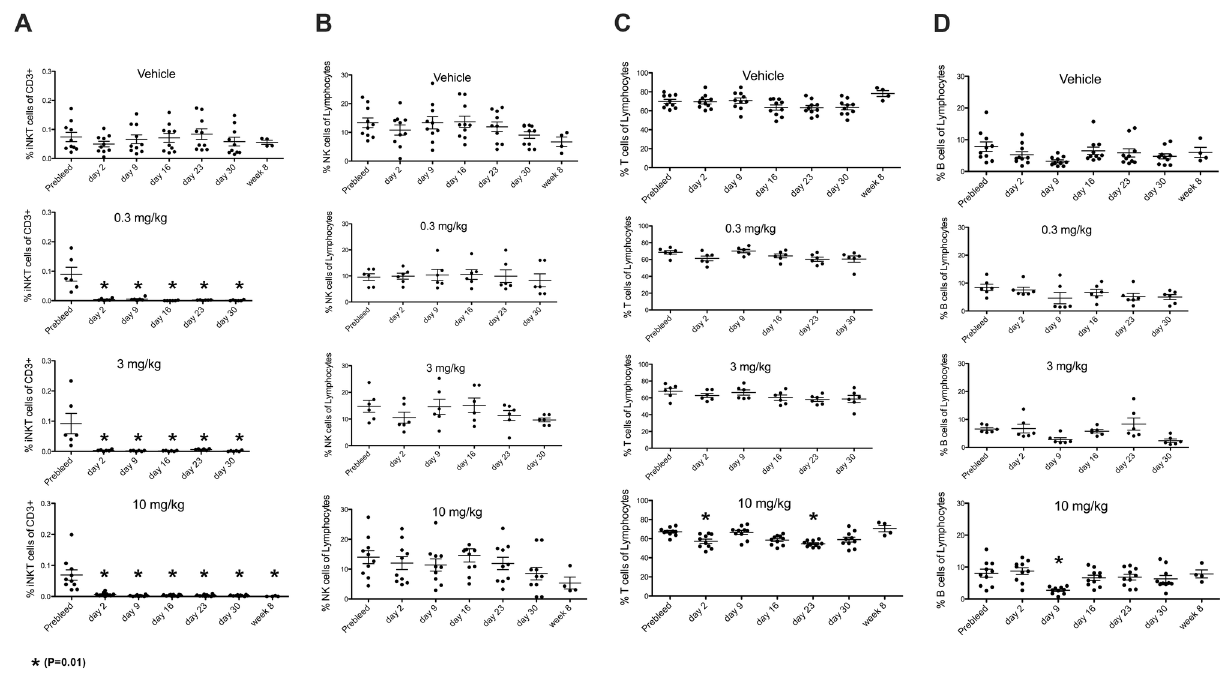
Figure 6. Cynomolgus macaques (n = 5 females + 5 males per group) were dosed and then weekly redosed for 4 weeks (total of 5 doses) with the indicated doses of NKTT120. Whole blood samples were drawn at indicated timepoints and stained with antibodies against CD3 (SP34.2), CD20 (2H7), TCR Vα24 (C15), CD159a (Z199) and invariant TCR (6B11). Red blood cells were subsequenltly lysed, cells washed and analyzed by flow cytometry. iNKT cells were cells identified as CD3+, Vα24+ and 6B11+ lymphocytes and reported as % of CD3+ cells ( A ). NK cells were identified as CD3-, CD159a+ lymphocytes and reported as % of lymphocytes ( B ). T cells were identified as CD3+, CD20- and 6B11- lymphocytes and reported as % of lymphocytes ( C ). B cells were identified as CD3-, CD20+ lymphocytes and reported as % of lymphocytes ( D ). One way ANOVA with multiple comparison followed by a non-parametric T test was performed using PRISM software on all the subsets. * indicates significant difference to pre-bleed values